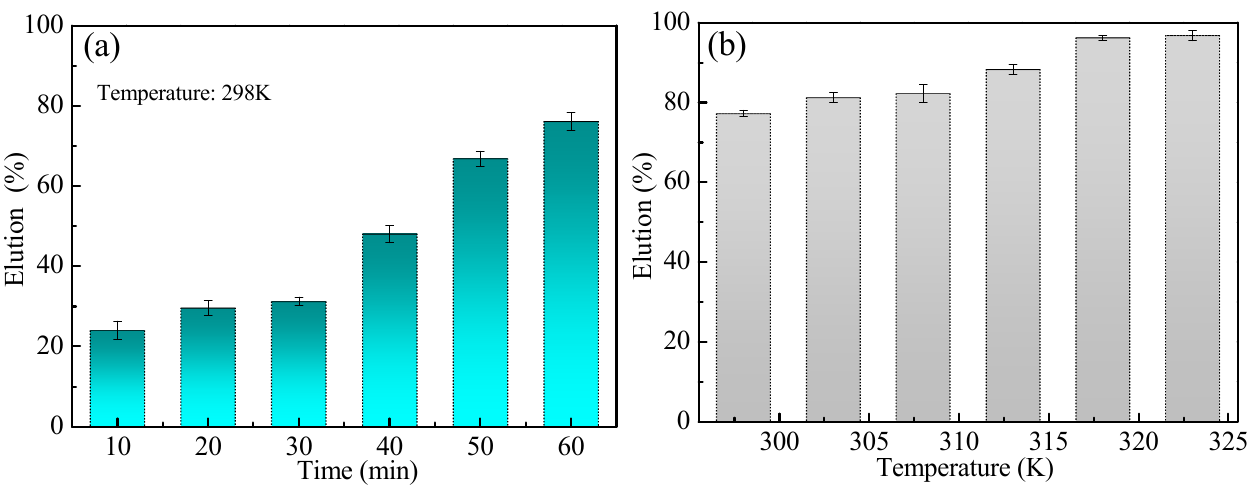
Figure 12. Variation of elution percentage of Pb(II) with ( a ) time and ( b ) temperature.